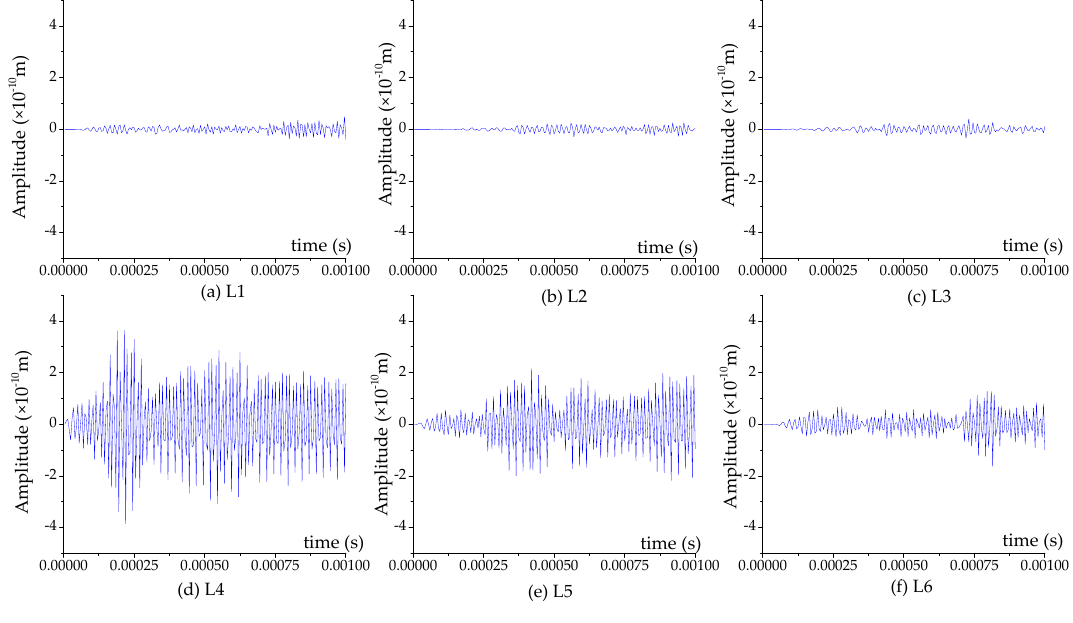
Figure 10. The displacement response at different locations at 50% grouting level.